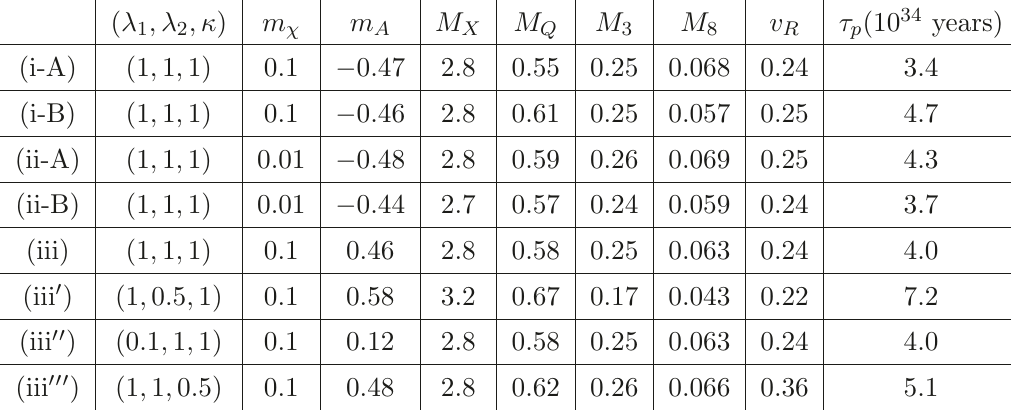
Table 1 . The p π 0 e + partial lifetime and the mass spectrum for various input values of λ 1 , λ 2 , κ → and m χ . The masses and VEV are in units of 10 16 GeV. From (i-A) to (ii-B), m A < 0 and thus a 24 is real and the mass spectrum splits into two, for which (i-A) and (ii-A) correspond to the cases with a 24 > 0, and (i-B) and (ii-B) to the cases with a 24 < 0. In (iii), m A > 0 and thus a 24